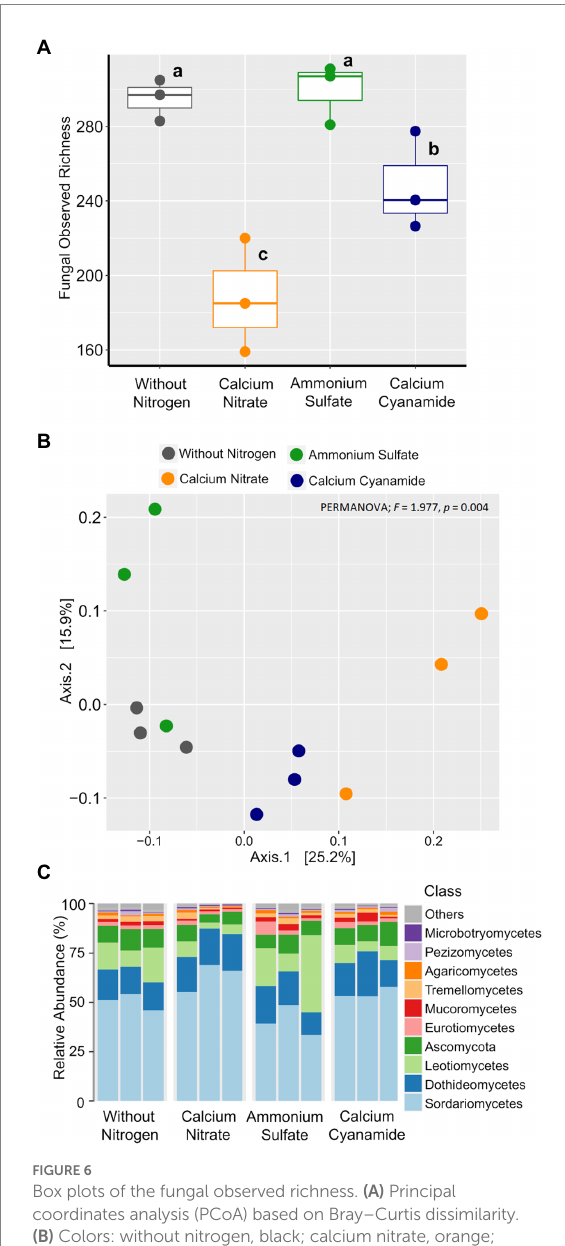
FIGURE 6 Box plots of the fungal observed richness. (A) Principal coordinates analysis (PCoA) based on Bray–Curtis dissimilarity. (B) Colors: without nitrogen, black; calcium nitrate, orange; ammonium sulfate, green; calcium cyanamide, blue. Effects of N fertilization were tested with PERMANOVA (based on Hellinger transformed data and the Bray–Curtis distance measure). (C) Mean relative abundance of the main classes of the fungal communities detected. The different lowercase letters indicate significant differences at 0.05 probability level according to Tukey multiple comparison